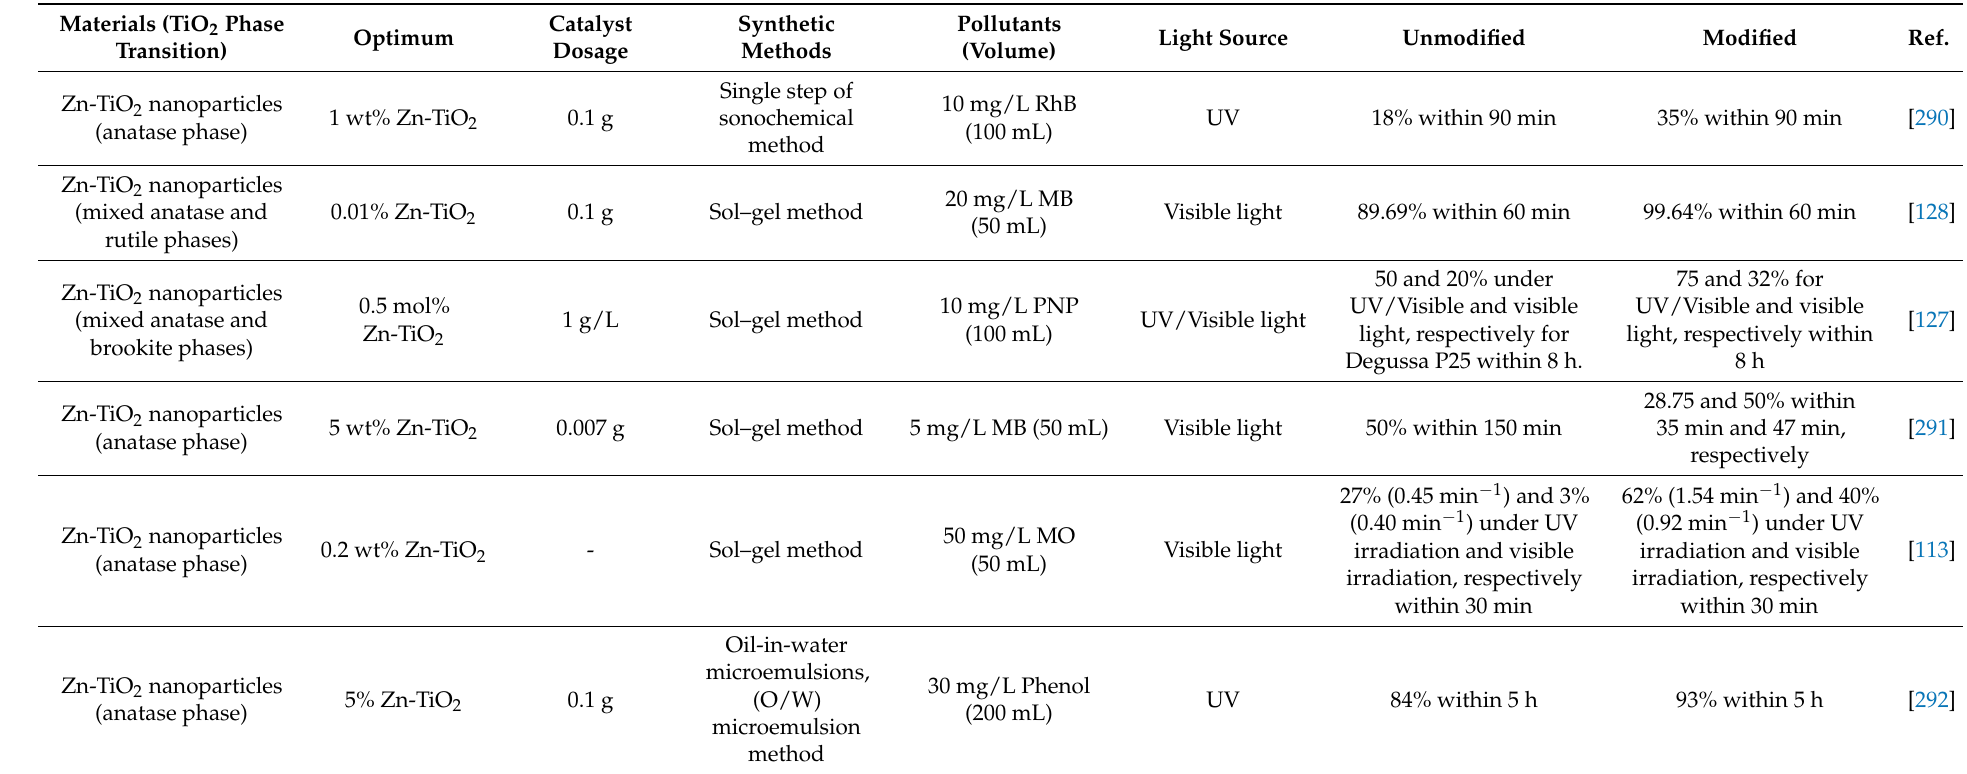
Table 14. Summary of recent progress on Zn-TiO 2 photocatalysts for organic pollutants